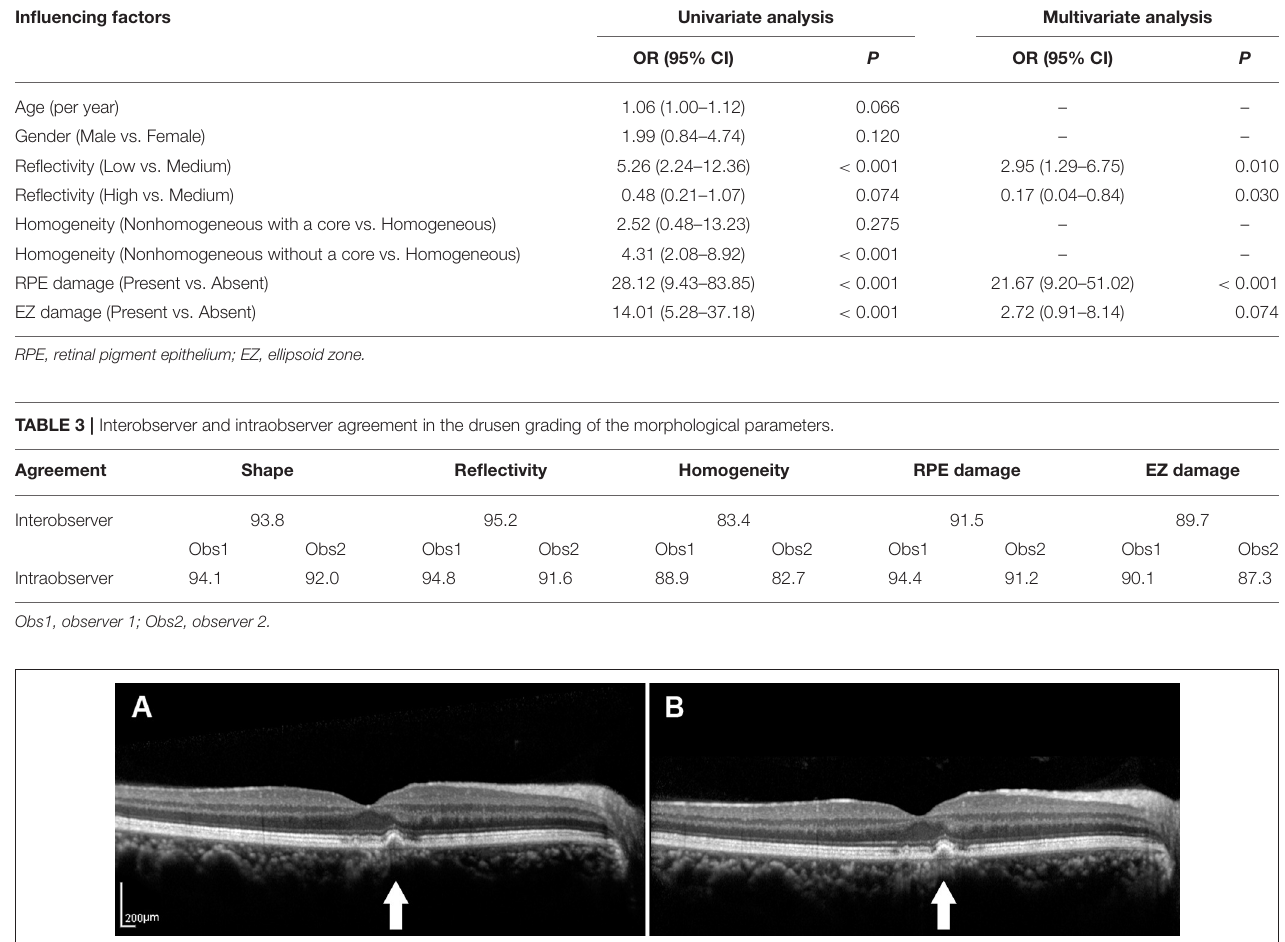
TABLE 2 | The generalized estimating equation (GEE) model analysis of the drusen progression factors. Influencing factors Univariate analysis